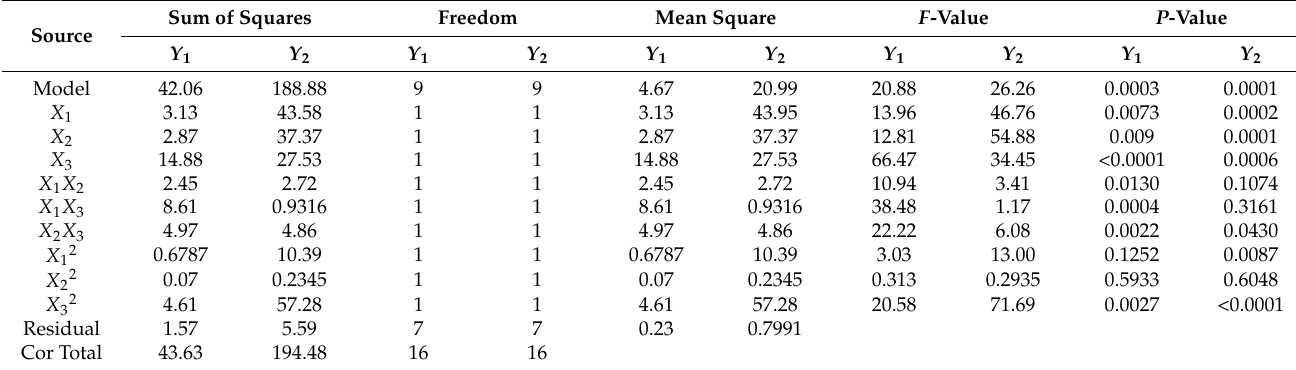
Table 4. Analysis of variance of response surface regression